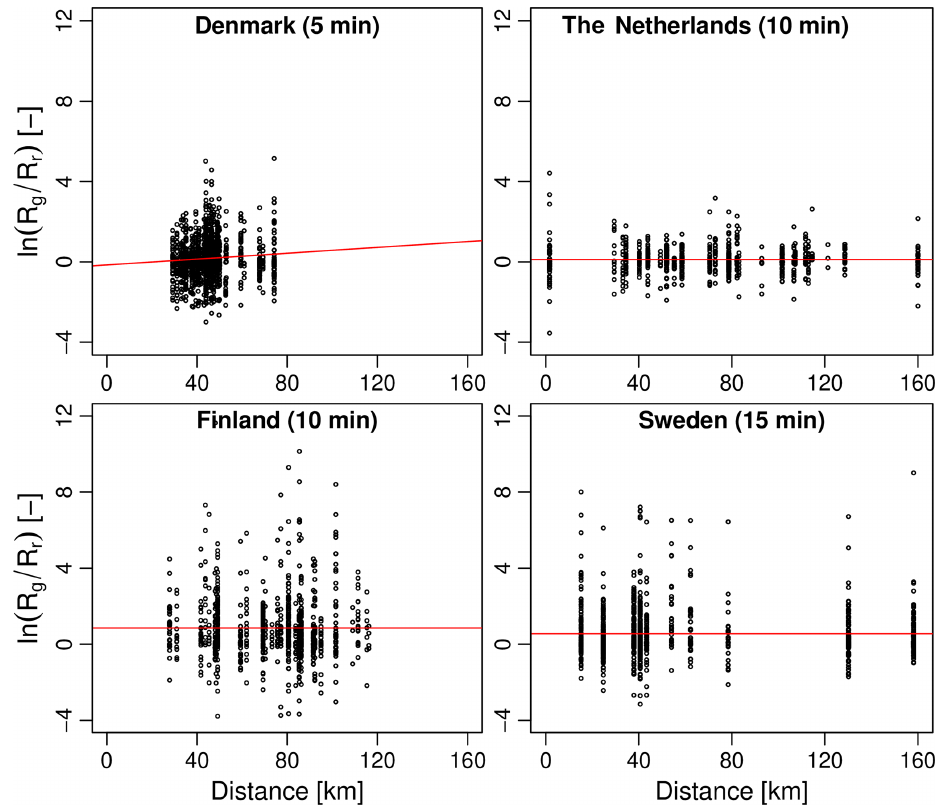
Figure 8. Log ratio of gauge over radar values as a function of the distance to the nearest radar. The red line represents the fitted linear regression